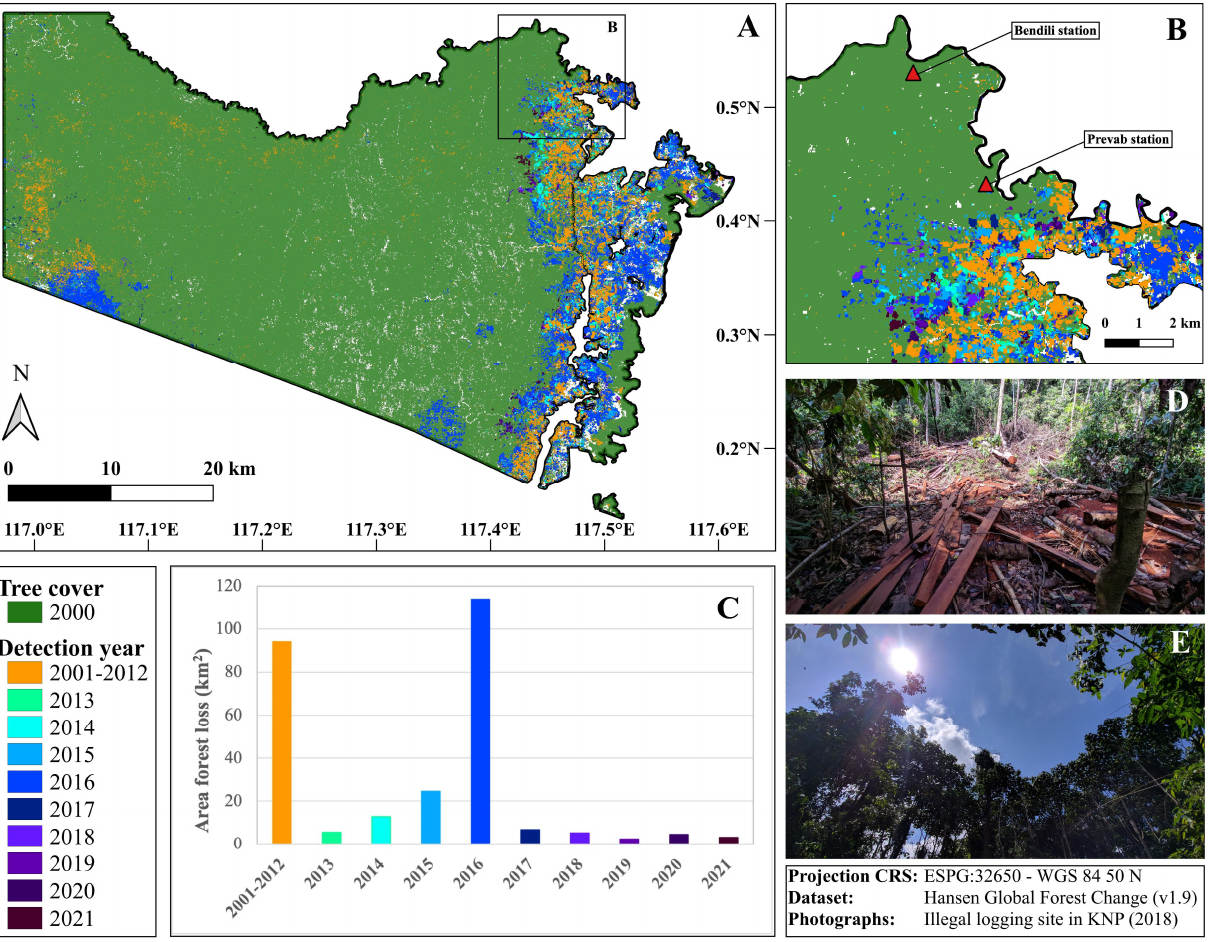
Figure 2. Classified areas of forest loss within Kutai National Park ( A ) and the Greater Mentoko Area [GMA] ( B ) between 2001–2021 and corresponding area estimates ( C ) as detected by the Hansen Global Forest Change (v1.9) dataset. Only years post-2013 are discretized annually due to higher detection accuracy of the 2013–2021 period. Tree cover with >70% canopy closure in year 2000 are depicted in green. Images of an illegal logging site ( D ) and the resultant canopy opening ( E ) in the GMA from 2018 by